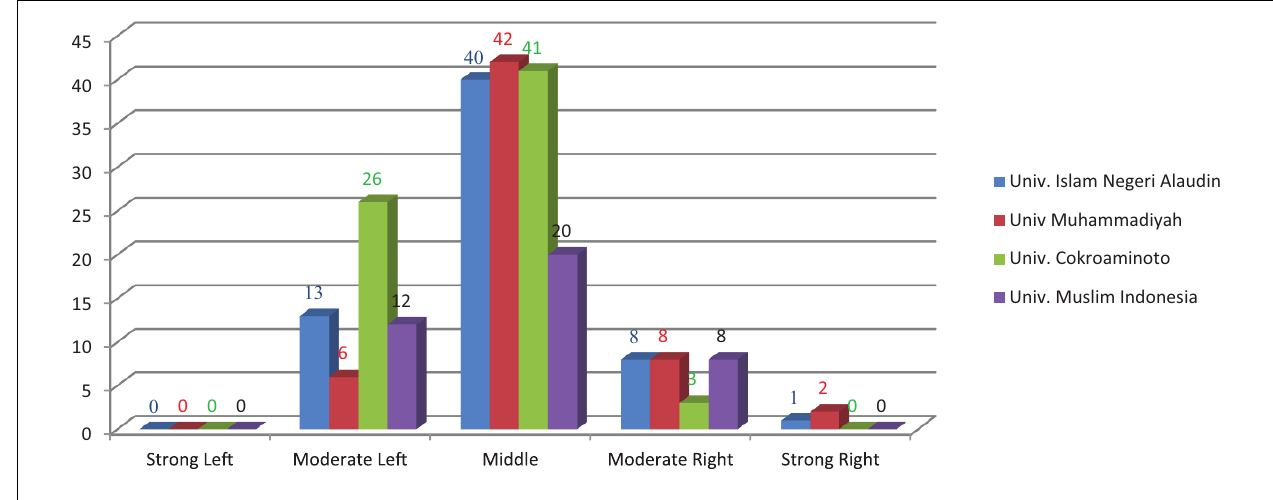
FIGURE 1 | Histogram of brain dominance